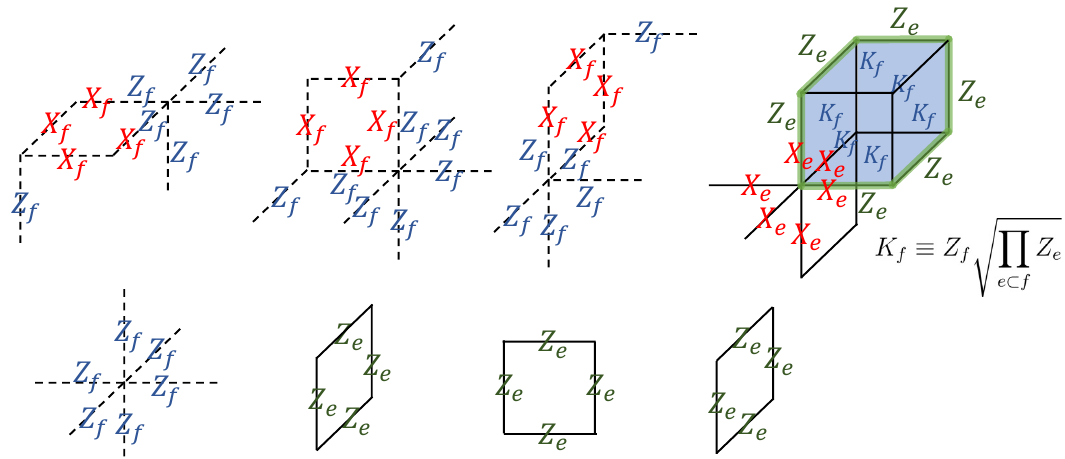
Figure 1: The Hamiltonian for the boundary state obtained by truncating the Hamil- tonian model of the beyond group cohomology invertible phase without symmetry in (4 + 1)D. There are qubits on the edges and faces of the lattice, acted on by the Pauli operators X , Y , Z and X , Y , Z , respectively. Solid lines in the figure are edges in e e e f f f the cubic lattice, while dashed lines are edges in the dual lattice, i.e. faces in the orig- inal lattice. The first row imposes the Gauss law energetically, and the second row imposes the zero flux condition energetically, which are violated by the excitations in Fig. 2. In the figure we omit the bulk terms. In the figure, K for the edges e , e , e , e that bound the face f , and the square root takes value in 1 2 3 4 { 1, i } in the eigenbasis of Z Z Z Z e 1 e 2 e 3 e 4